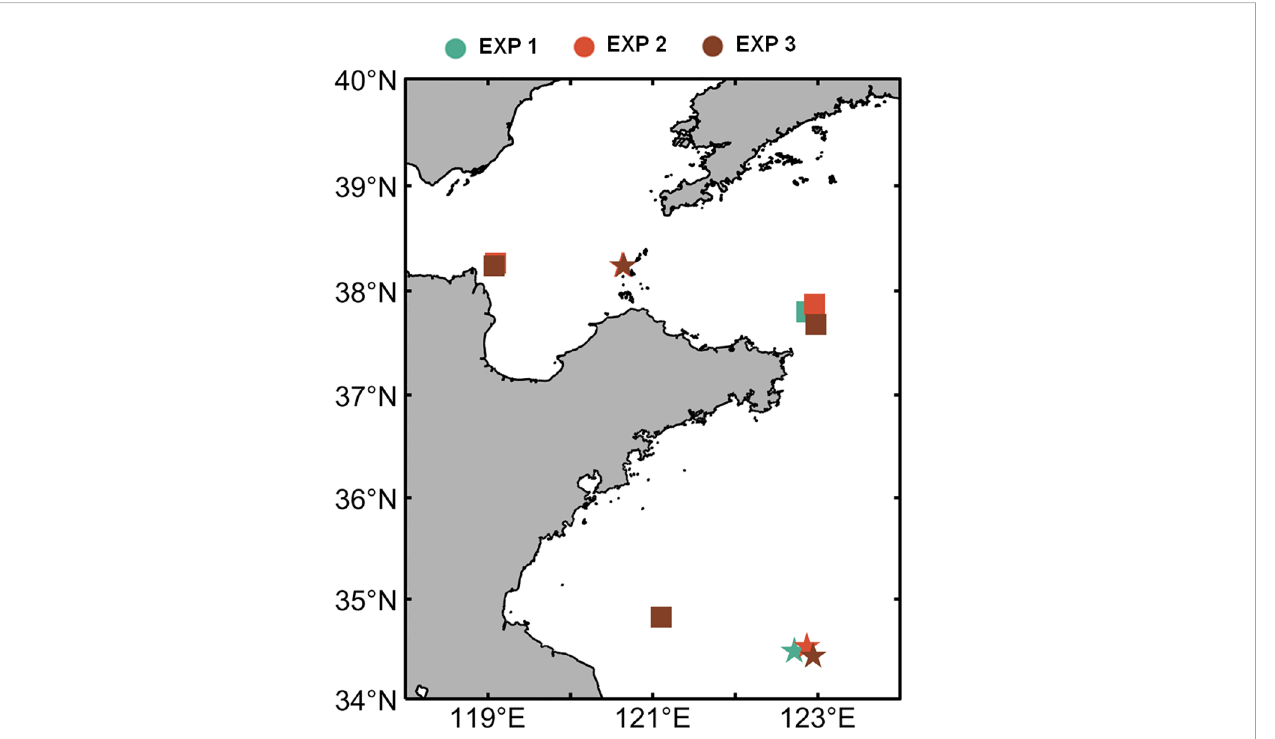
FIGURE 7 Locations of amphidromic points of M 2 tide (rectangles) and K 1 tide (pentagrams), respectively. Colors denote different